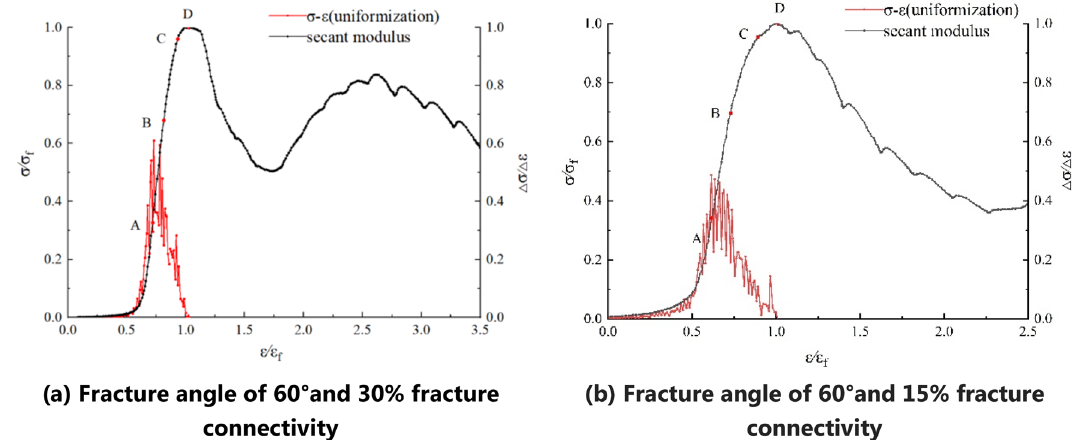
Figure 6. Stress–strain curve and secant modulus curve of a fractured soft rock-like-like